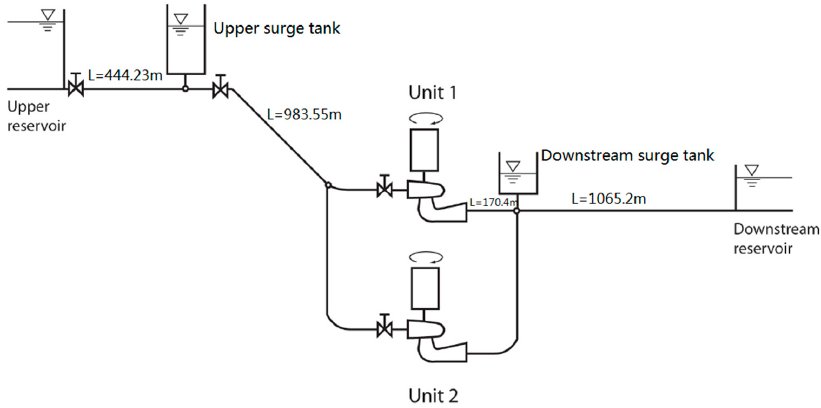
Figure 14. Structure of the water diversion system.